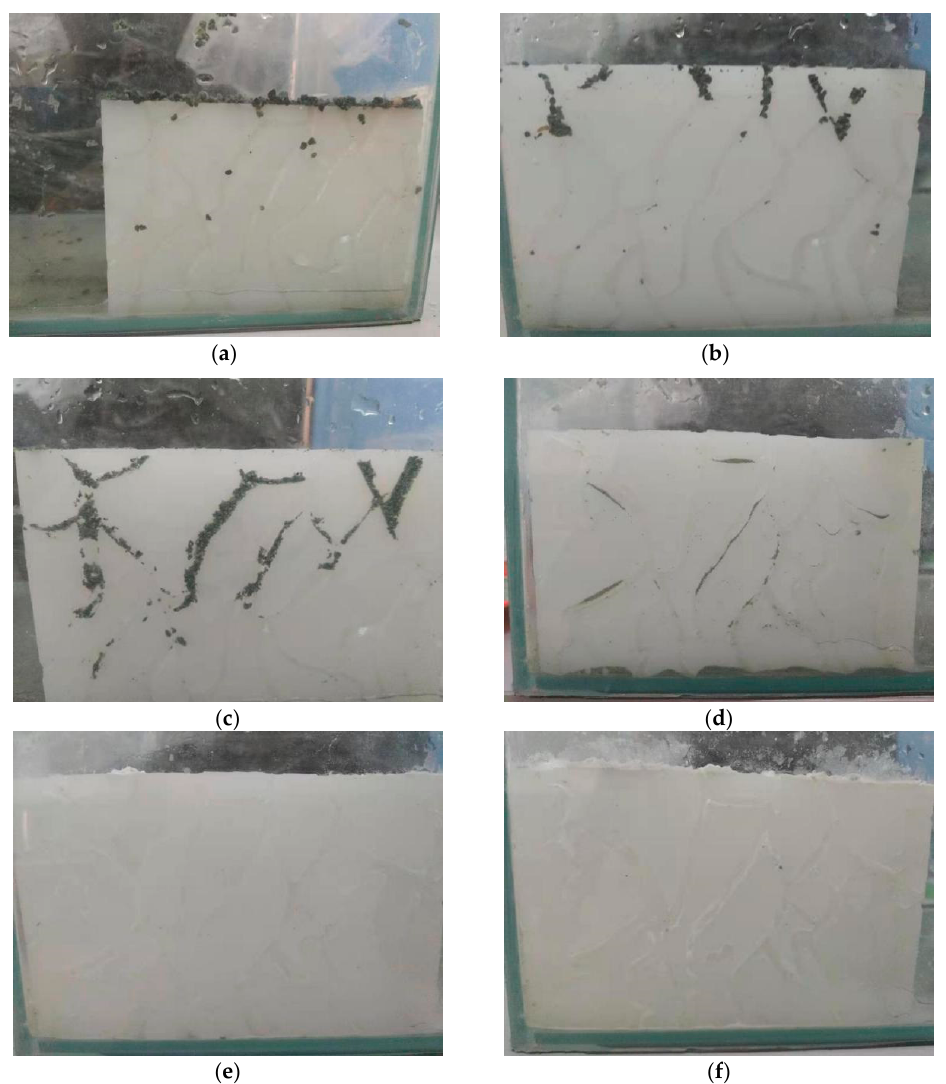
Figure 8. Blockage of full-graded blockage.